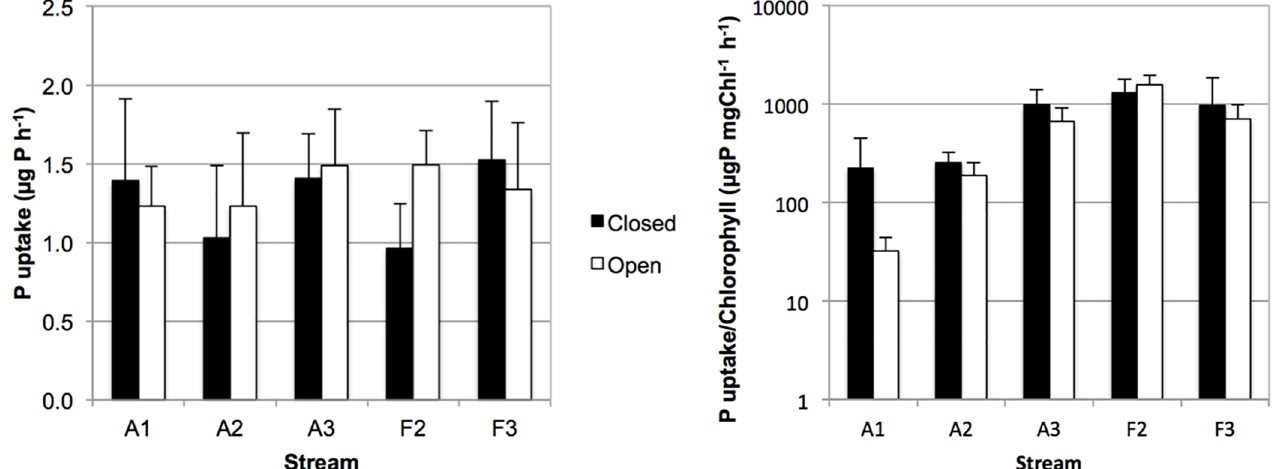
Fig 2. Phosphate uptake by biofilm carriers. Black columns, closed reaches, white columns, open reaches of agricultural (A) and forest (F) streams. Left panel, phosphate uptake by pair of biofilm carriers. Right panel, phosphate uptake by unit chlorophyll. Values are arithmetic means, error bars show standard deviation.